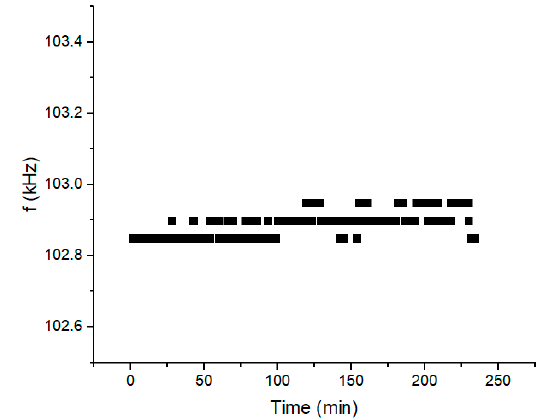
Figure 3. Measurement of the sensor resonance frequency for a period of 4 h under the presence of plain air, to check for the sensor stability.